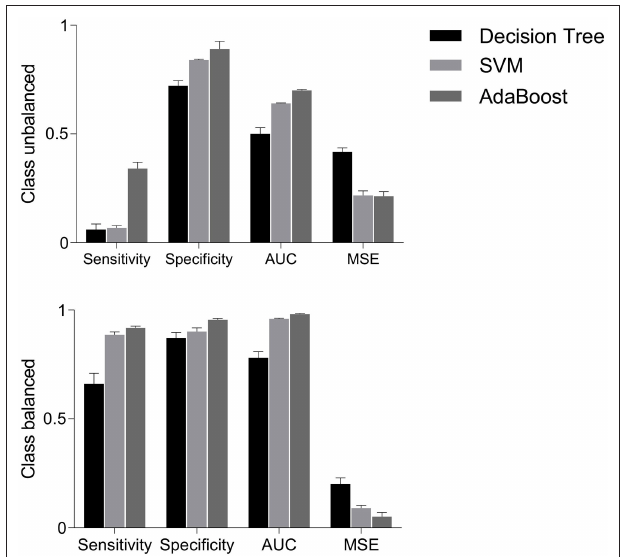
FIGURE 6 | Performance measures i.e., sensitivity, specificity, AUC and MSE, using decision tree, SVM and AdaBoost classifiers for balanced and unbalanced classes. AUC, area under the ROC curve; MSE, mean squared error; SVM, support vector